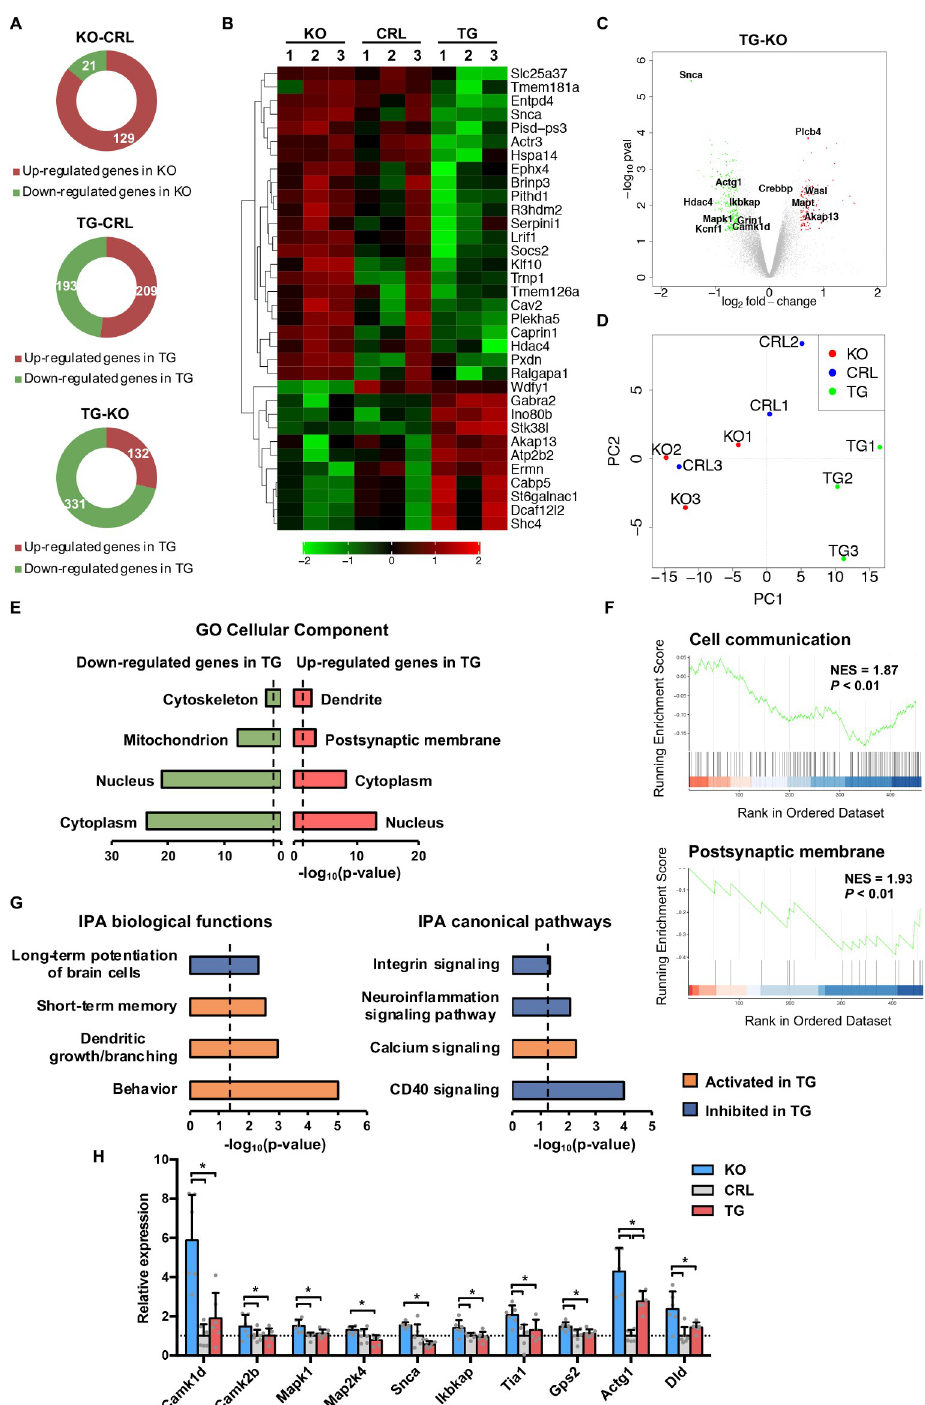
Fig 3. IF1 affects gene expression programs of neuronal function. (A) Differentially expressed genes identified in the 3 comparisons among IF1 KO , CRL, and IF1 TG mice. (B) Heatmap showing genes exhibiting statistically significant ( P < 0.05) and 2-fold or greater increases between IF1 KO and IF1 TG mice. (C) Volcano plot showing differentially expressed genes in IF1 TG vs. IF1 KO comparison. (D) PCA of the 3 genotypes. (E) Gene enrichment analysis of the down- and up-regulated transcripts in IF1 TG with respect to IF1 KO mice, showing the GO cellular components. The dashed line shows the significance threshold. (F) Enrichment plots of top hits obtained from GSEA. (G) IPA of biological functions and canonical pathways with their predicted activation/inhibition status. The dashed lines show